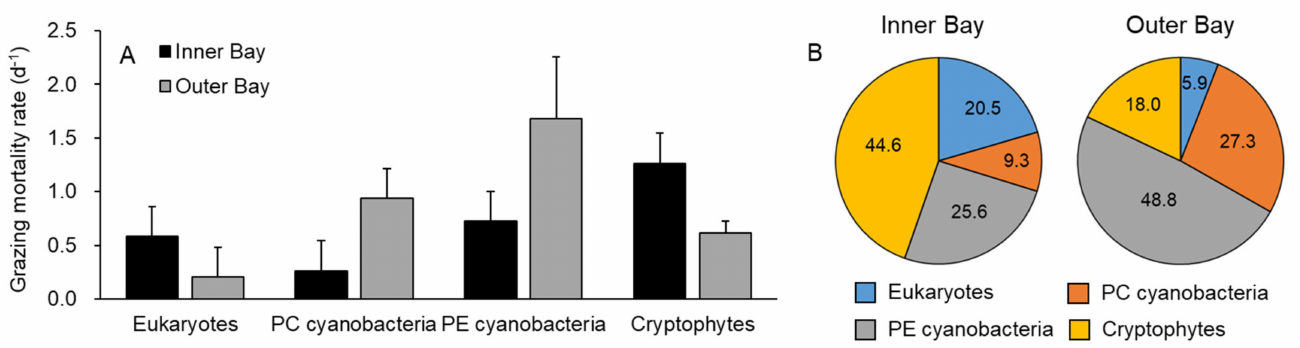
Figure 8. Grazing mortality rates (d − 1 ) and relative grazing rates (%) of the major phytoplankton groups as estimated using flow cytometry. ( A ) Grazing mortality rates of the major phytoplankton groups and ( B ) relative grazing rates of the major phytoplankton groups in the inner and outer bays. Abbreviations are as follows: PC cyanobacteria = phycocyanin-containing cyanobacteria, PE cyanobacteria = phycoerythrin-containing